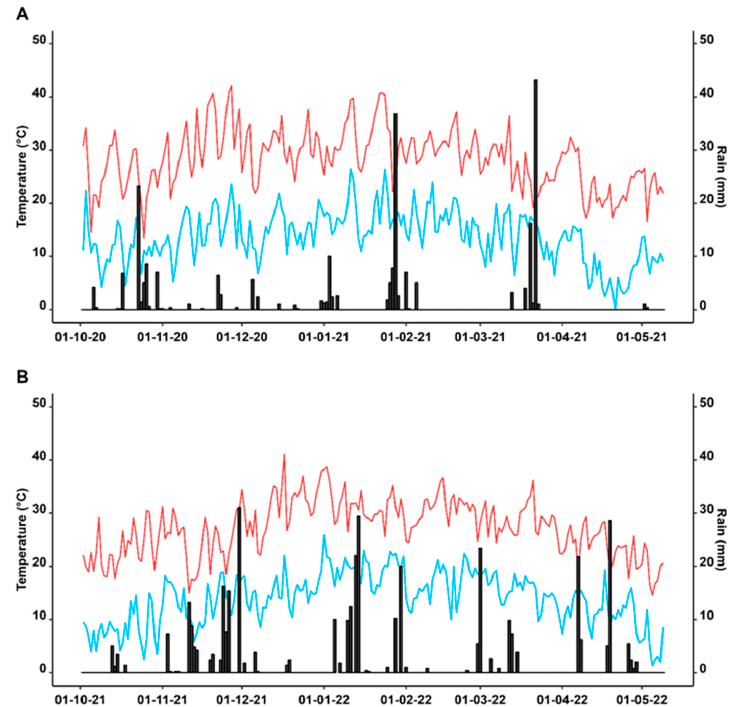
Figure 1. Maximum ( red ) and minimum ( blue ) temperatures and rainfall (bars) recorded in Year 1 ( A ) and Year 2 ( B ).